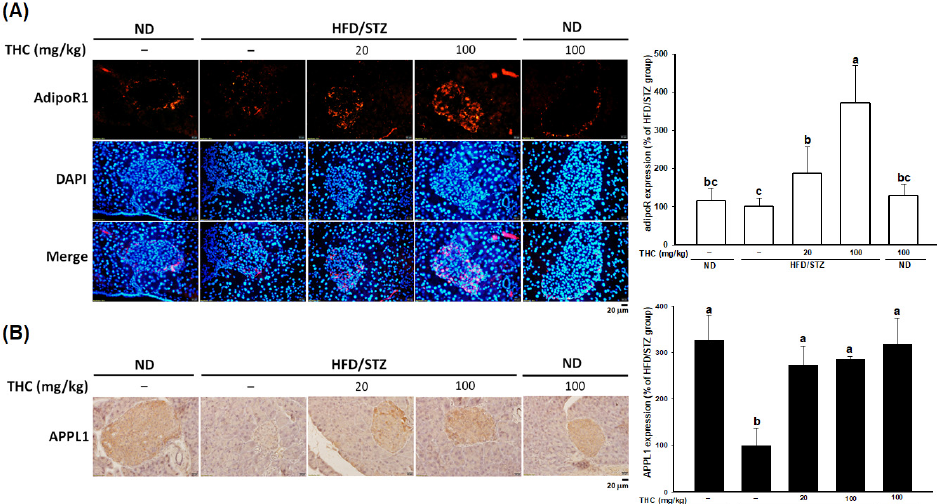
Figure 7. Upregulation of AdipoR1 and APPL1 in pancreatic islets by THC in HFD/STZ treated mice. ( A ) Immunofluorescence staining of AdipoR1 (red) and DAPI (blue) in pancreas sections. ( B ) APPL1 expression was detected in pancreas sections by immunohistochemical analysis. Quantification of AdipoR1 and APPL1 was performed by ImageJ. Data are expressed as mean ± SEM ( n = 5–6). Statistical differences ( p < 0.05) between groups were evaluated by one-way ANOVA with Tukey’s post-hoc test and were labeled as different letters (a, b, and c).